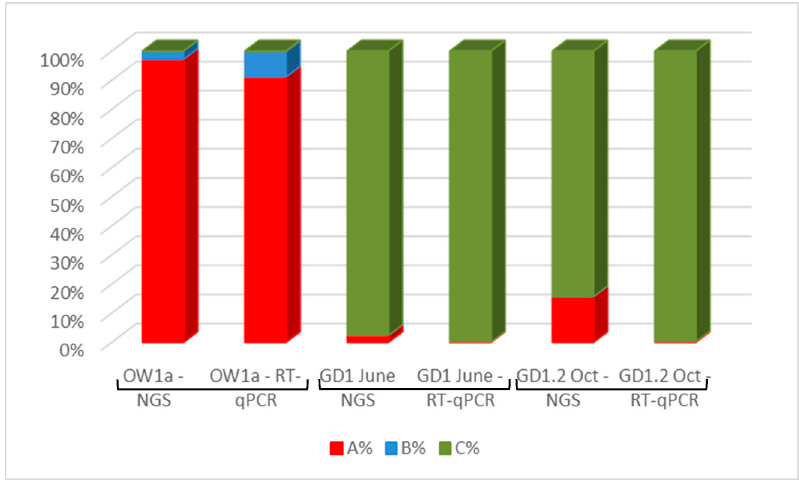
Figure 5. Comparison of ABC assay and NGS data for honey bees. Red = DWV variant A, blue = DWV variant B, and green = DVW variant C.